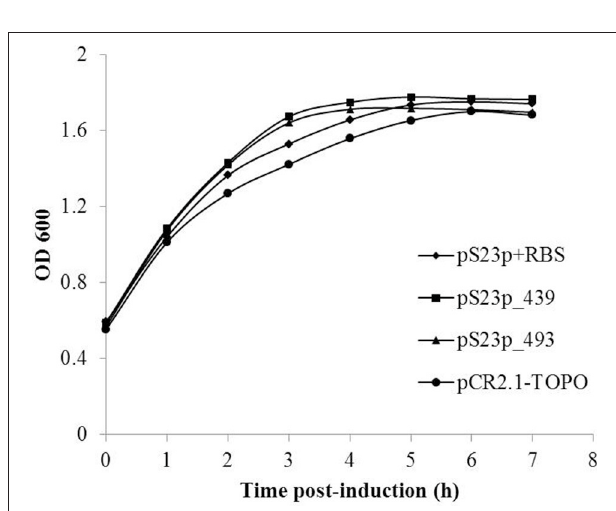
FIGURE 7 | Effect of C. burnetii ’s S23p on E. coli’s growth. E. coli strains IRW201 (diamond, pS23p + RBS), IRW202 (square, pS23p_439), IRW203 (triangle, pS23p_493), IRW204 (circle, pCR2.1-TOPO vector) were induced with IPTG (1mM) and assayed spectrophotometrically at 600 nm for growth at 37 ◦ C. A representative of two indistinguishable assays is